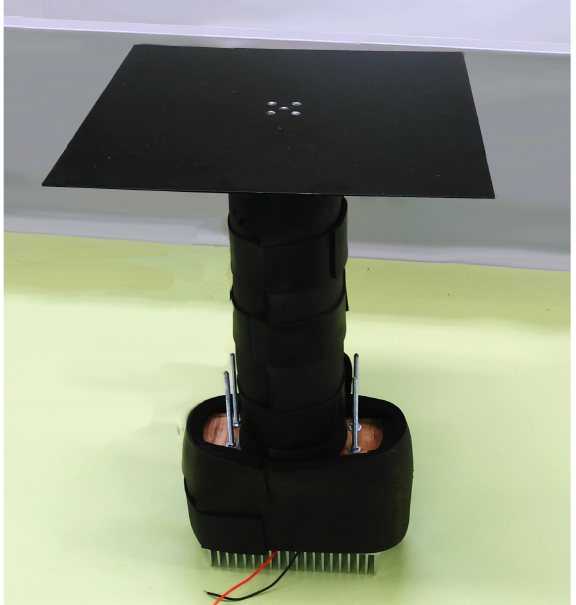
Figure 6. Prototype of the TEG solar flat panel with buried heat